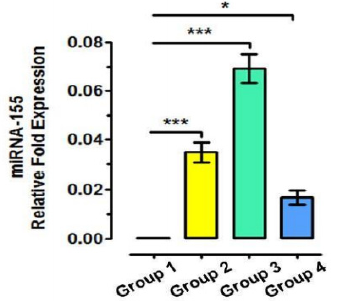
Figure 2. Relative fold expression of MIR155 among groups. Controls: 145 Systematically and periodontally healthy pregnant women. Group A: 100 Systematically healthy pregnant women with chronic periodontitis. Group B: 100 Preeclamptic pregnant woman with chronic periodontitis. Group C: 100 Preeclamptic pregnant woman without chronic periodontitis. * statistically significant, *** highly statistically significant . ‖‖ Version V, SanDiego, CA, USA.